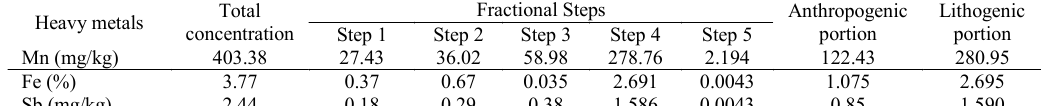
Table 9: Chemical bonds of heavy metals in Hamedan City soils